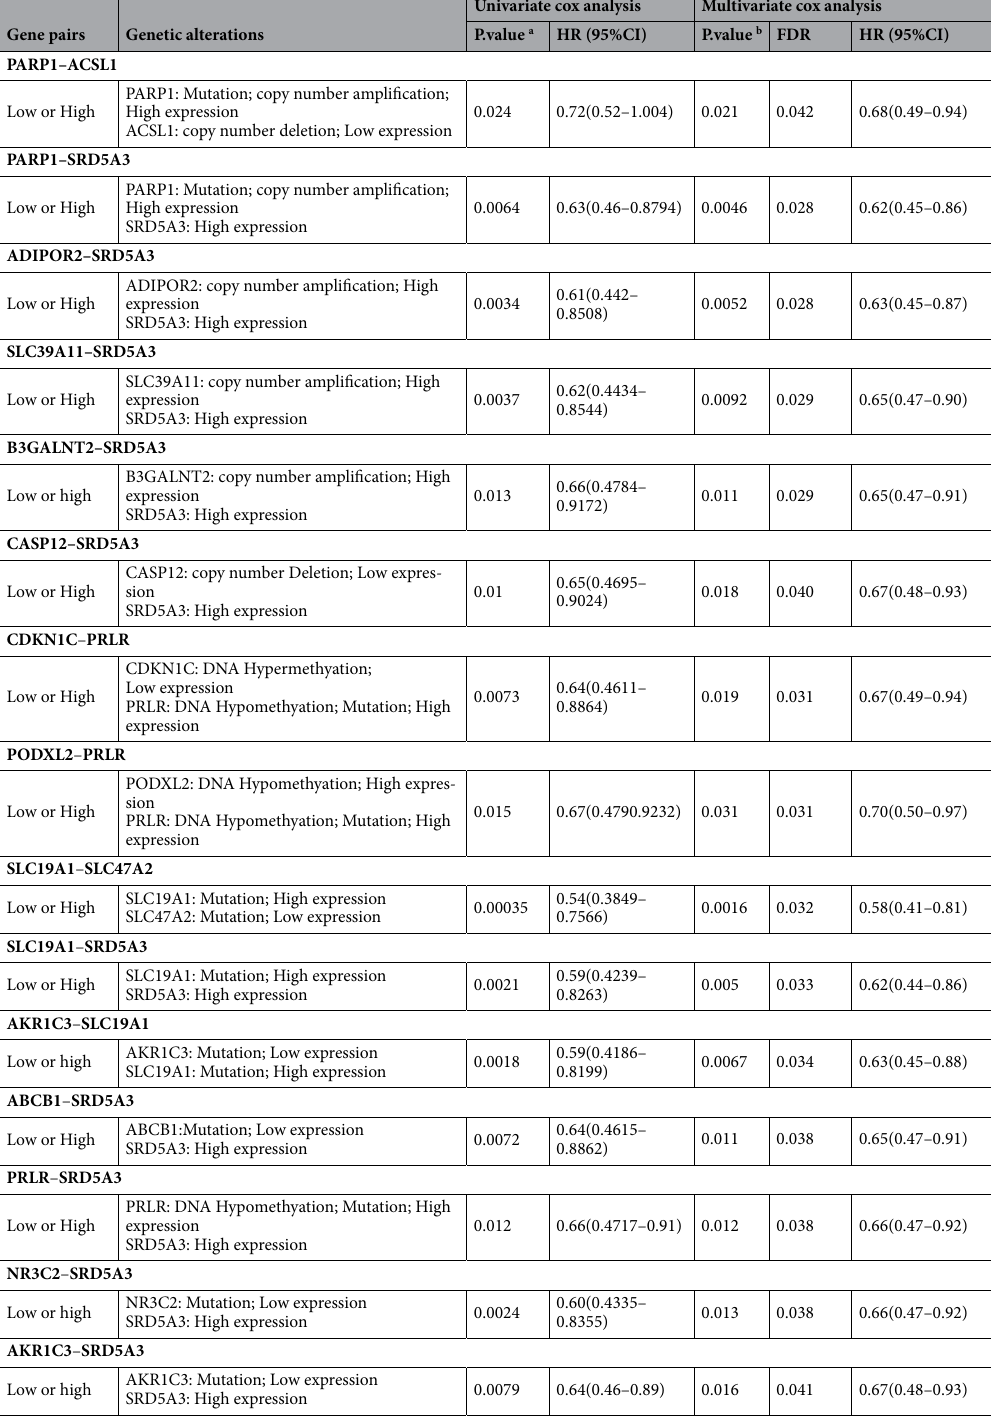
Table 1. The information of pairs of genetic alteration-driven genes and drug response genes associated with survival in breast cancer. HR: hazard ratio. a P.value: Univariate Cox regression analysis. b P.value: Multivariate Cox regression analysis (including age, ER, PR, pathological stage), FDR: FDR correction for P.value b